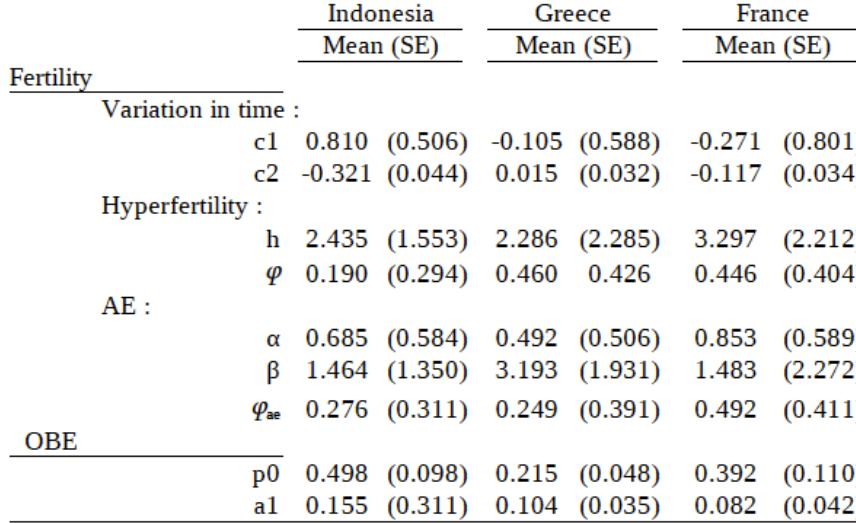
Table 3. Parameters estimates when AE and FBOE are simultaneously considered. Mean and standard deviation (SE) of the parameter posterior distribution. The proportion of individuals concerned ( φ and φ ae ) is indicated for parameter values dependent on a latent variable. The variation in time is described by the intercept ( c 1 ) and a slope ( c 2 ). See text for interpretation of the parameters.